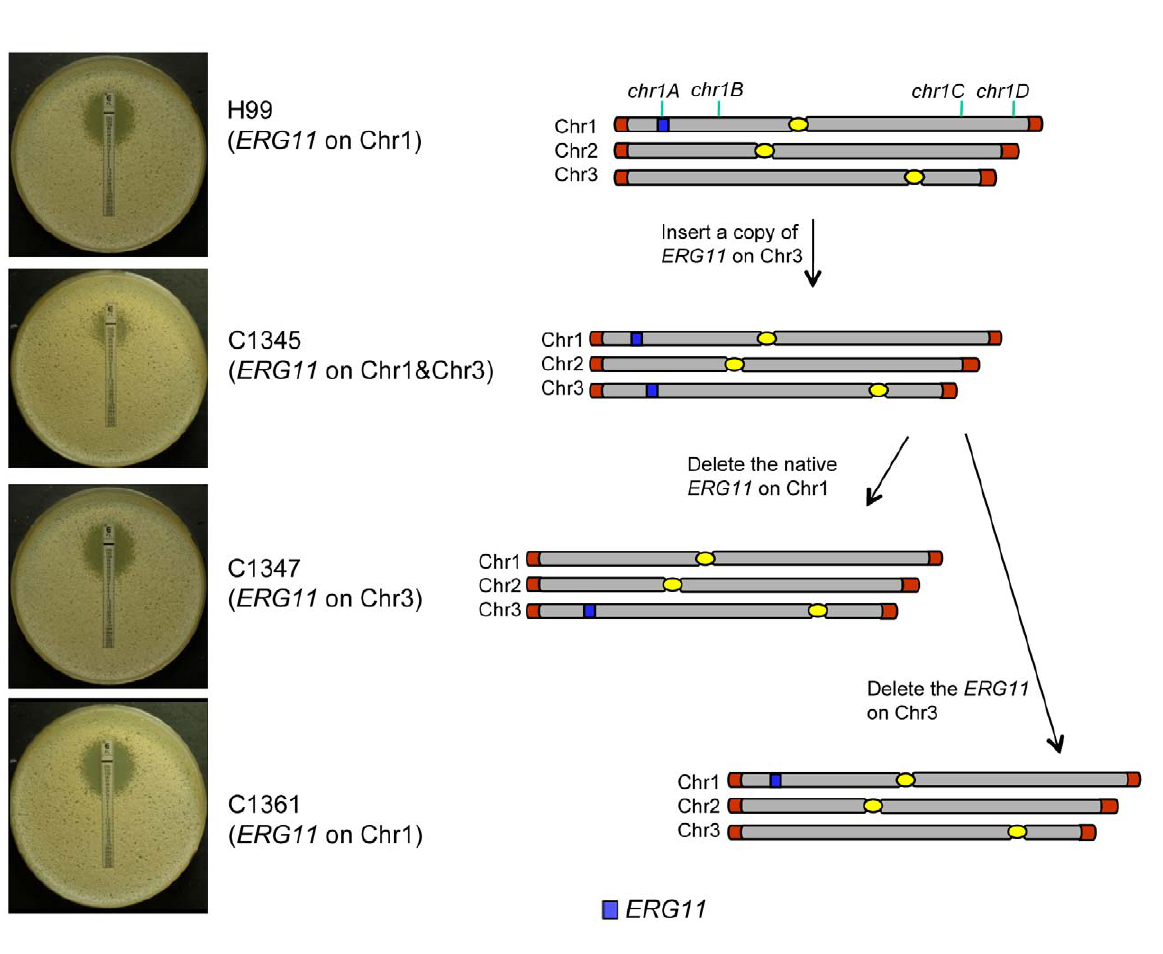
Figure 5. The correlation between ERG11 location and the phenotype. The diagram on the right represents the chromosomal location of ERG11 and its corresponding phenotype is shown on the left (FLC E-tests). The position of 4 tested genes ( chr1A , chr1B , chr1C , and chr1D ) on Chr1 is indicated at the top of the diagram.